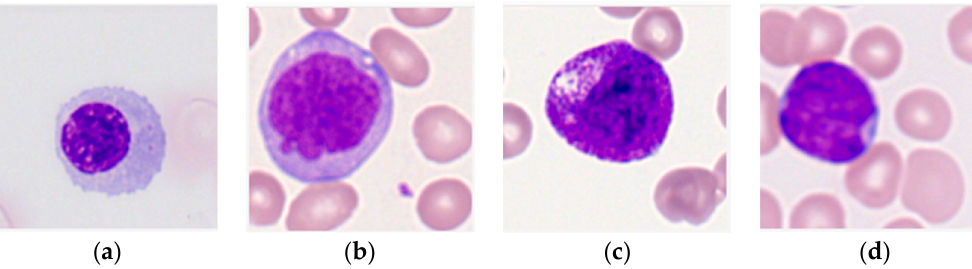
Figure 1. Sample images of the four types of immature leukocytes in acute myeloid leukemia (AML) patients [20,21] used in this study. Each image is centered around a leukocyte and contains background cells. ( a ) Erythroblast; ( b ) monoblast; ( c) promyelocyte; ( d) myeloblast.